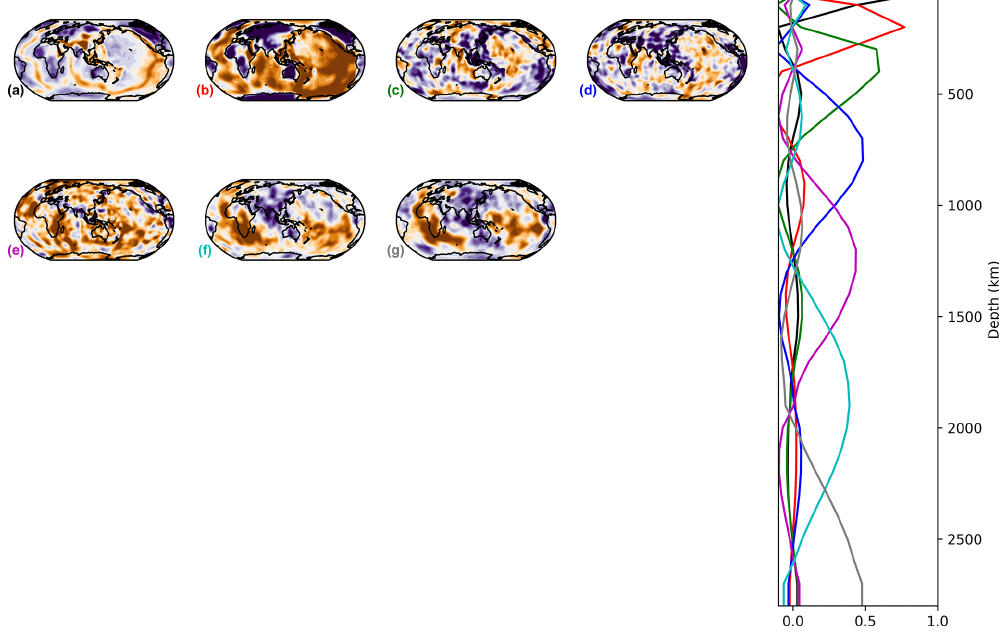
Solid Earth, 12, 1601–1634,